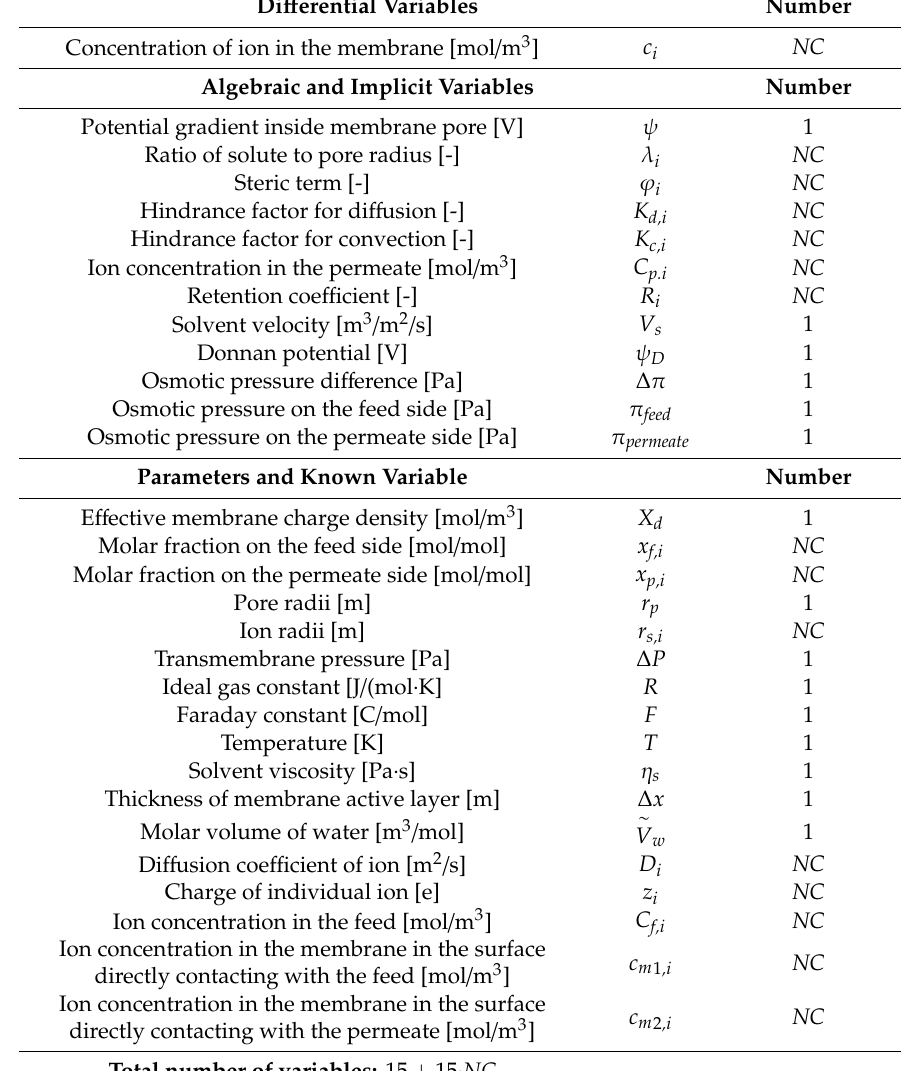
Table 1. Variables in Donnan–Steric partitioning model (DSPM) (NC—number of components).